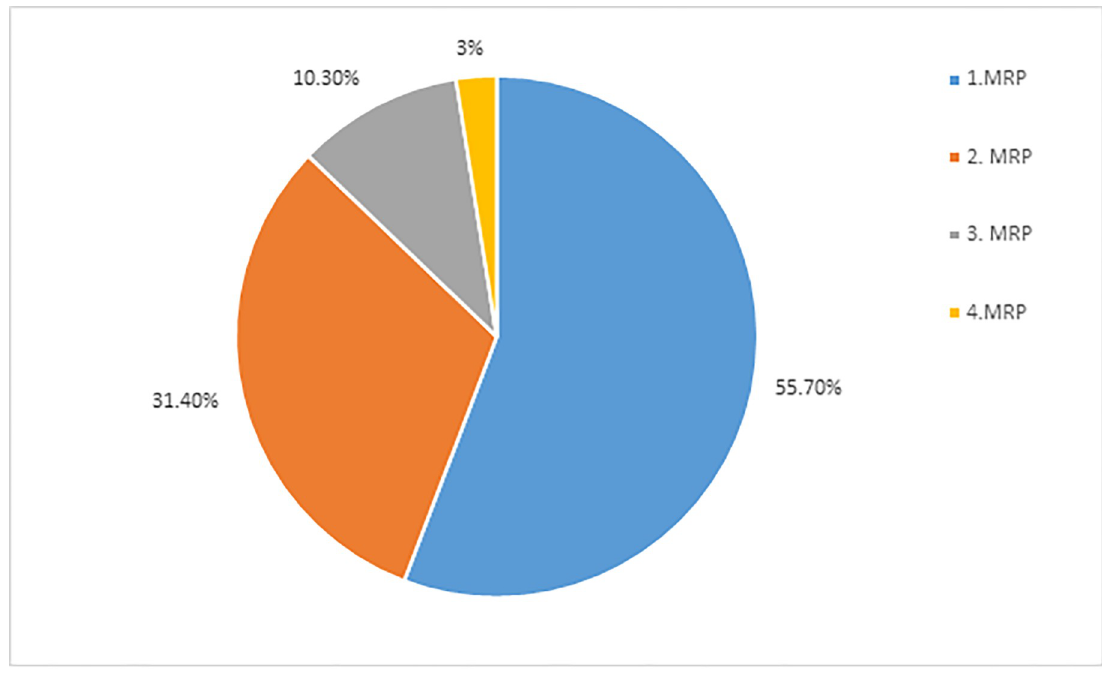
Fig 2. Number of medication related problems per patients among CKD patients having follow-up at renal clinic of St’s Paul’s Hospital Millennium Medical College, Addis Ababa, Ethiopia, June -August, 2019.